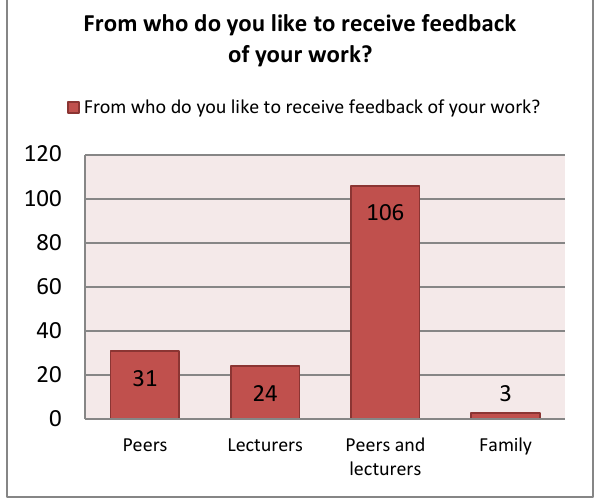
Figure 7. Preferred people to give